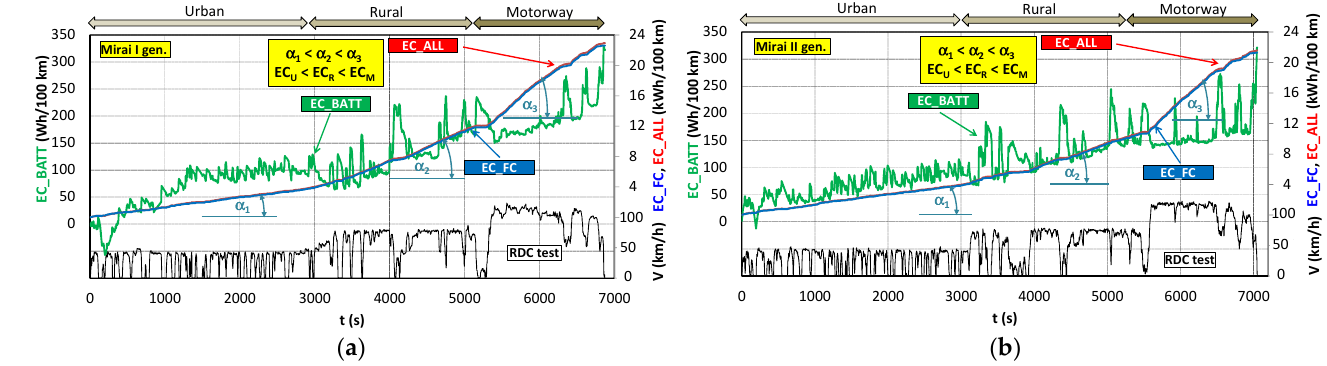
Figure 15. The use of battery and fuel cells energy in road tests of both generations of Toyota Mirai drives: ( a ) first generation; ( b ) second generation.